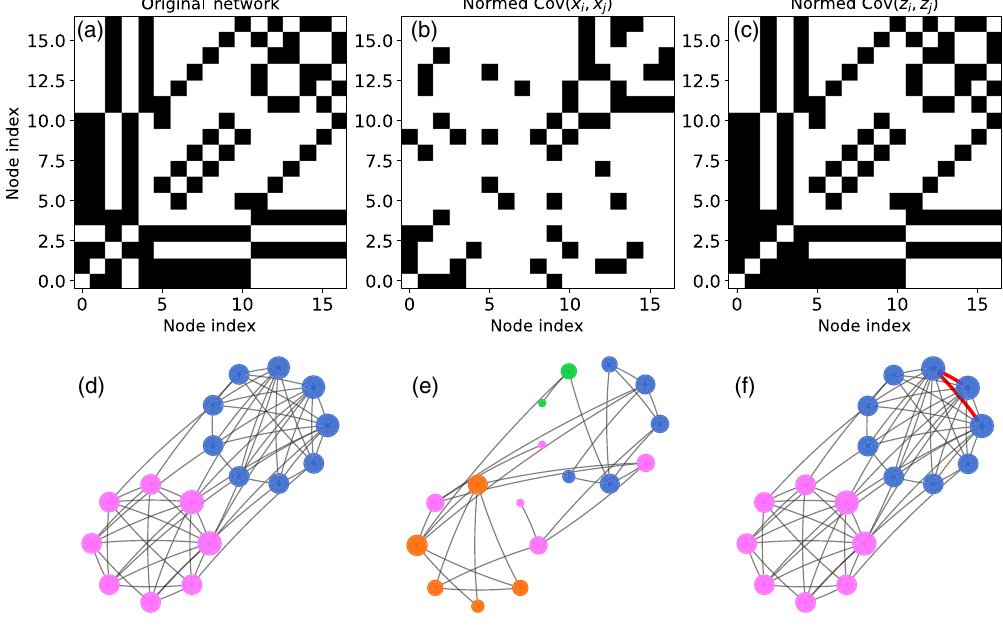
FIG. 6. Effective network from experimental data of networks of optoelectronic oscillators. We consider multivariate time series of voltages of a network of 17 weakly coupled optoelectronic oscillators (interaction corresponding to 1% of the oscillator amplitude). In the left-hand panels, we show the actual network used to couple the optoelectronic oscillators in Ref. [52] as adjacency matrix in (a) and graph representation in (d). In the middle panels, we show the reconstruction of the network by a functional network analysis in terms of its adjacency matrix in (b) and graph representation in (e). In the right-hand panels, we show the reconstruction of the network from an analysis of the dynamical fluctuations by applying the effective network approach as adjacency matrix in (c) and graph representation in (f). The effective network provides a striking reconstruction and only two links are misidentified and are indicated in (f) as red links. In the graph representation, the nodes of the network are colored according to the community obtained by a community detection algorithm